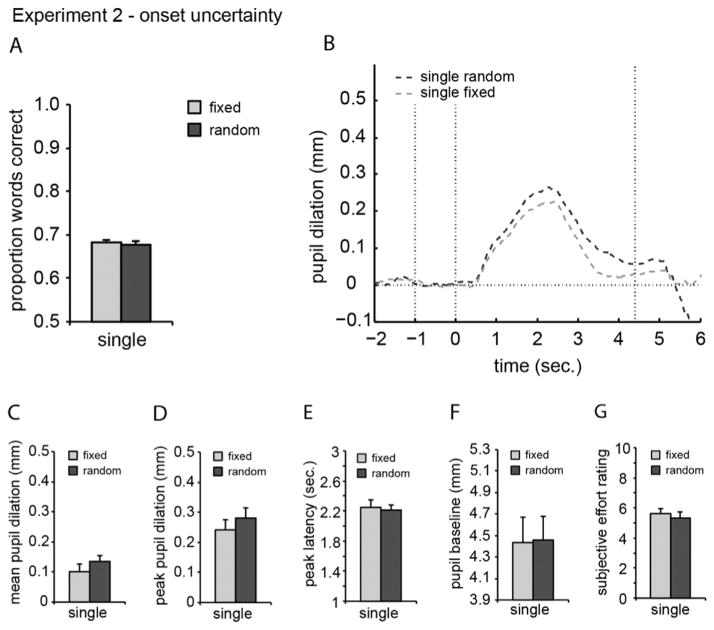
As Fig. 1, but for Experiment 2.